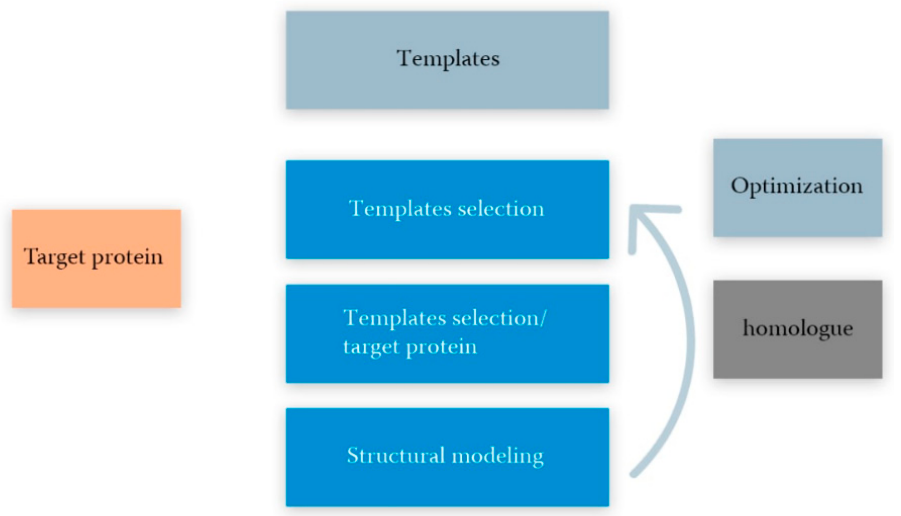
Figure 5. Main stages of comparative modeling of protein structure, including template selection, alignment of template-target protein sequences, modeling of the target protein structure, and quality assessment (optimization).